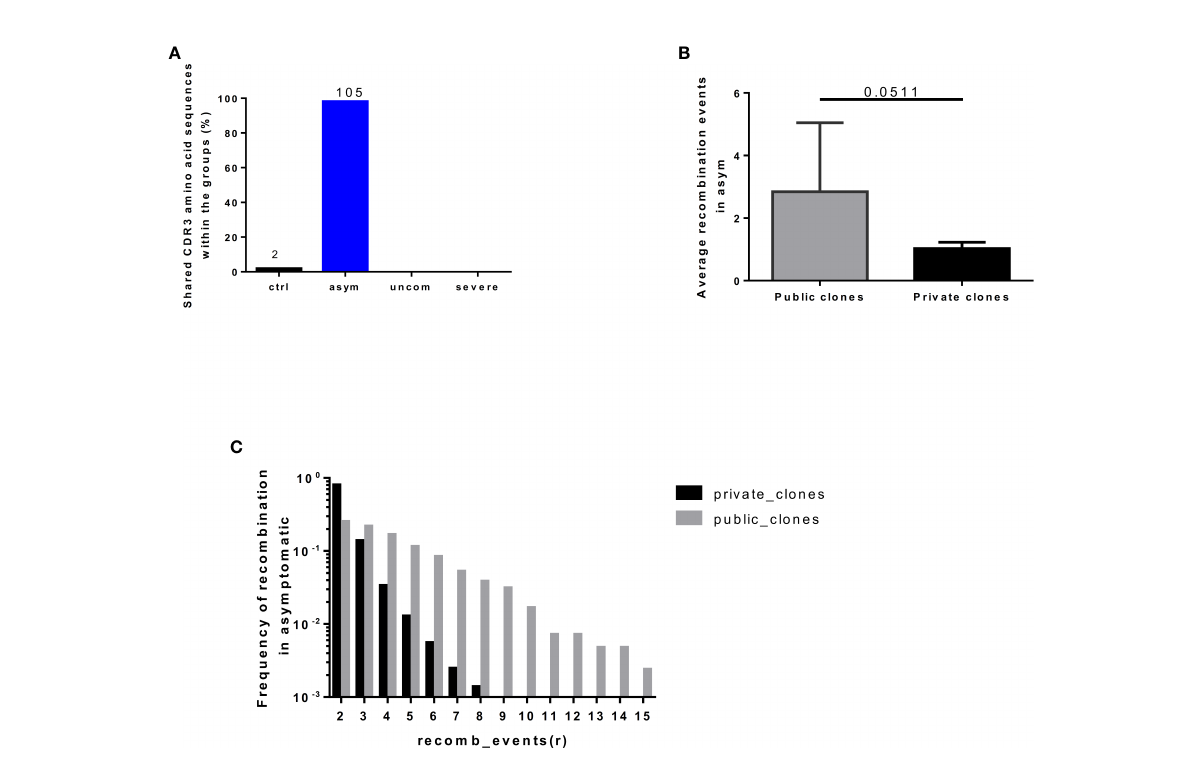
FIGURE 5 Frequency of recombination events in public and private clones. The number of (A) shared clones found in individuals in each group. (B) Average recombination events in the asymptomatic group (C) Degree of convergent recombination events in the public and private clones occurring in the asymptomatic group at threshold of 2<=r<=15, recombination events. The plot shows the mean and standard deviation. Data presented in boxplot shows inter-quartile ranges with horizontal lines indicating the